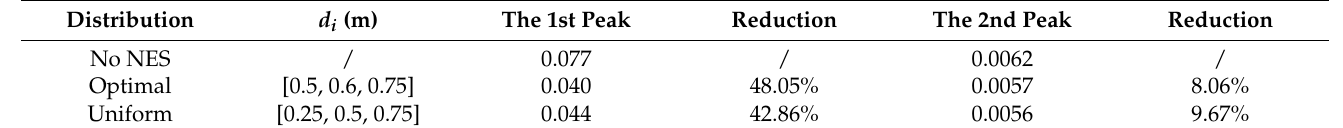
Table 3. Comparison of the performance between different distributions of parallel NESs.